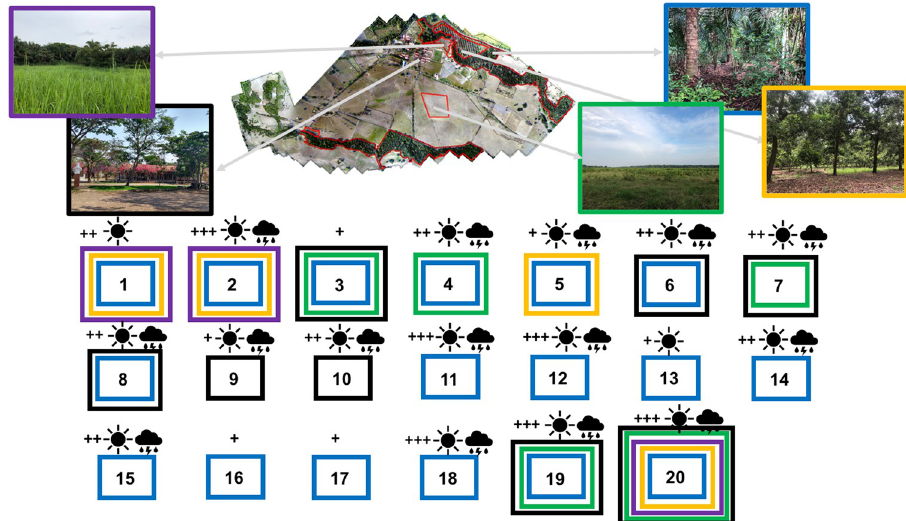
Fig 8. Potential host mammals of A . mixtum seen by people in the habitats of the Matepantano farm. Color of every box (blue = Riparian Forest; orange = Cocoa Crop; violet = King Grass Crop; green = Star Grass Paddock; black = administrative buildings; bedrooms, classroom, and restaurant) represent every habitat and other areas where the potential host has been seen by locals. Also, the sun symbol represents host presence in the dry season, while the rain clouds stands for host presence in the wet season. The ‘+’ symbol indicates the minimum perception of relative host abundance in the habitat, while the ‘+++’ represents the maximum perception. Note that host could have been seen in different habitats (several colored boxes). The animals species identified by locals based on photographs and common names have been identified by numbers and organized by rows from the left to the right and their common and scientific names (the last one between parentheses) are written as follows: 1) Armadillo ( Dasypus novemcinctus ); 2) capybara ( Hydrochoeris hydrochaeris ); 3) porcupine ( Coendou prehensilis ); 4) black agouti ( Dasyprocta fuliginosa ); 5) deer ( Odocoileus virginianus ); 6) flat-faced fruit-eating bat ( Artibeus planirostris ); 7) anteater ( Myrmecophaga tridactyla ); 8) Seba’s short-tailed bat ( Carollia perspicillata ); 9) fox ( Urocyon cinereoargenteus ); 10) opossum ( Didelphis marsupialis ); 11) tufted capuchin ( Cebus apella ); 12) Colombian red howler ( Alouatta seniculus ); 13) collared peccary ( Pecari tajacu ); 14) South American tapir ( Tapirus terrestris ); 15) southern tamandua ( Tamandua tetradactyla ); 16) puma ( Puma yagouaroundi ); 17) margay ( Leopardus wiedii ); 18) cat ( Felis catus ); 19) cow ( Bos taurus indicus ); 20) horse ( Equus ferus caballus ). Except for the last three species, all 17 animals seen by locals in the habitats are wild species. Both domestic and wild animals use to be around the administrative buildings. Bolded scientific names belong to A . mixtum hosts reported [30].